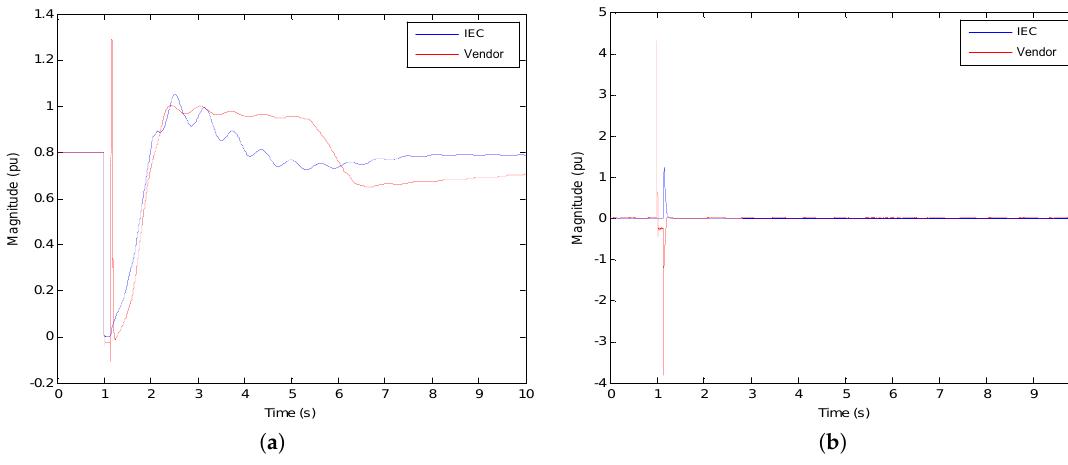
Figure 9. Type IIIB results. Simulation scenario: p = 0.80 pu, u = 0.01 pu, t = 140 ms. ( a ) Active power, p ; and ( b ) reactive current, i q .